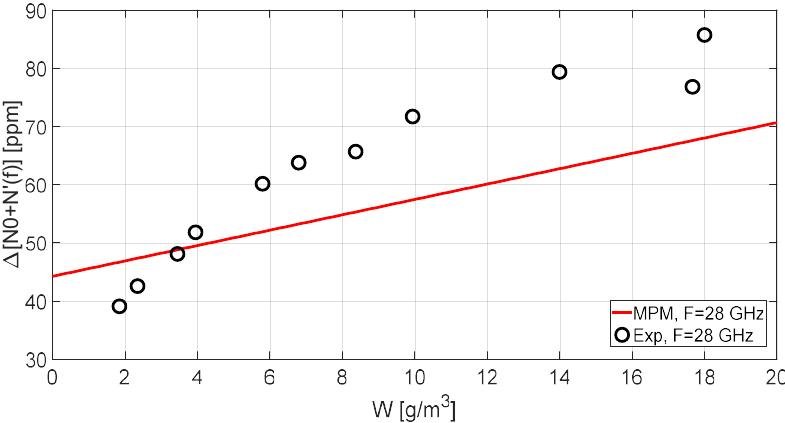
Figure 14. Simulation and experimental results for the real part of refractivity at 28 GHz. Environmental conditions: T = 16 ◦ C, P = 101 kPa, RH = 100% (For reference, RH = 60% for clear